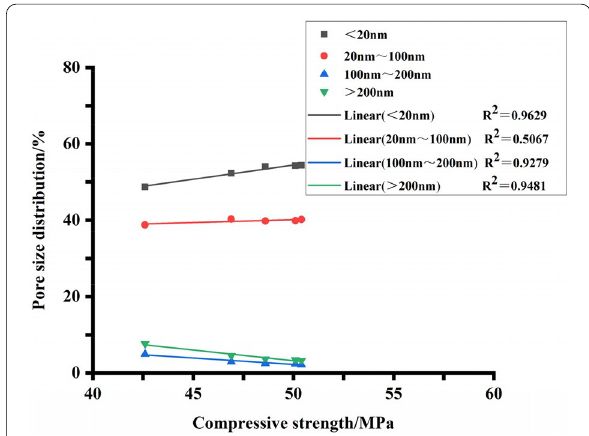
Fig. 23 Relationship between pore size distribution and splitting tensile strength (C).